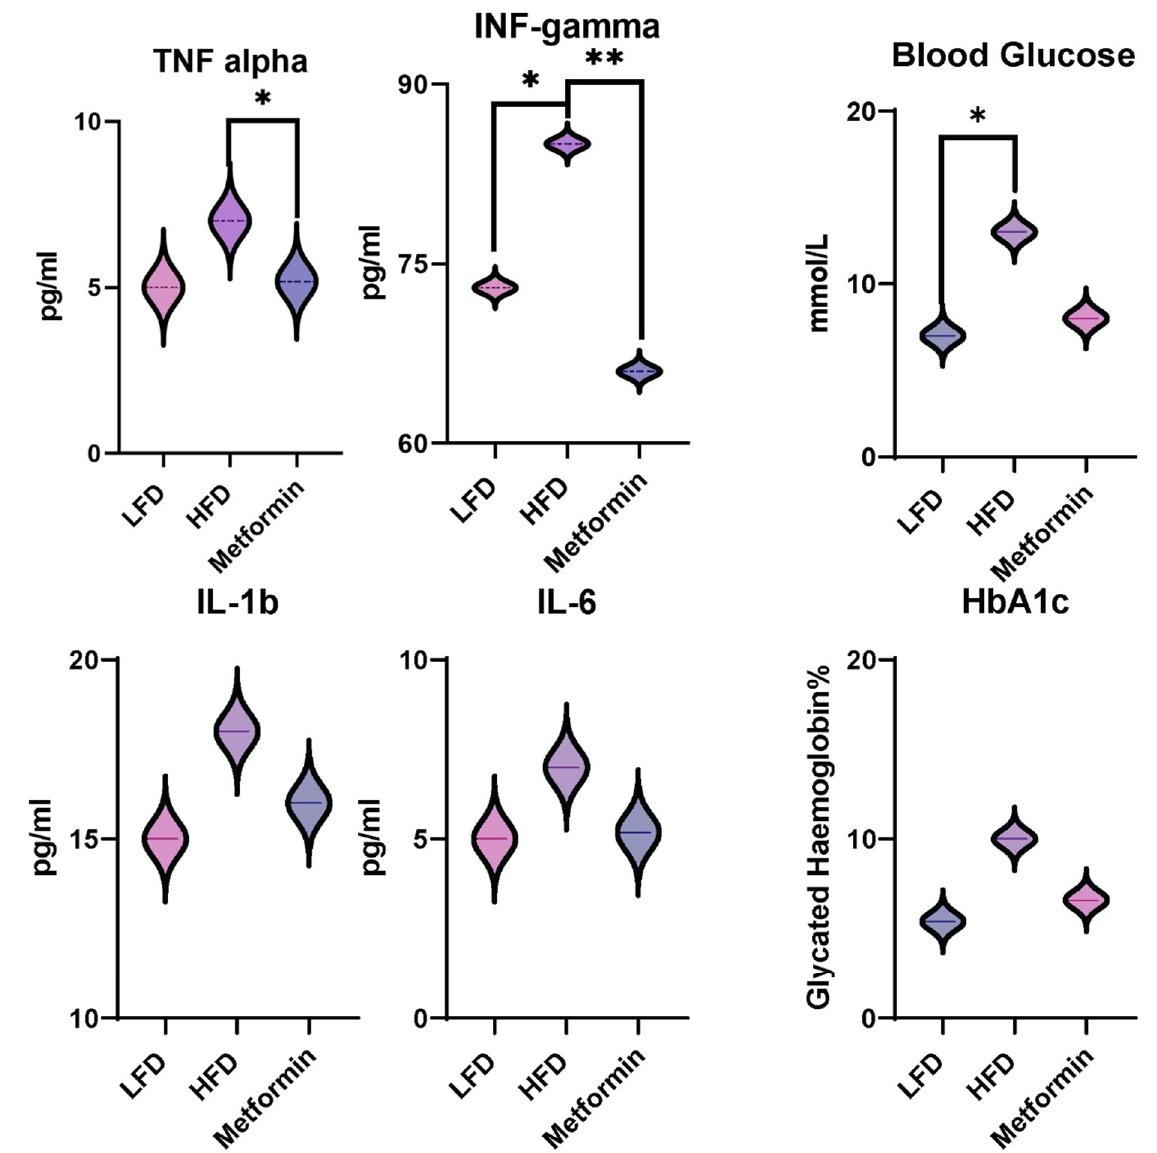
Figure 2. Inflammatory profile of plasma and blood glucose levels and glycated haemoglobin ( 2 ); n = 8, mean. HFD = high-fat diet, LFD = low-fat diet, M = metformin-treated, TNF-alpha = tumour necrosis factor-alpha, IFN-gamma = interferon-gamma, IL-6 = Interleukin—6, IL-1 beta = interleukin-1 beta. The data are presented as mean ± SEM ( n = 6). * p < 0.05, ** p < 0.01.